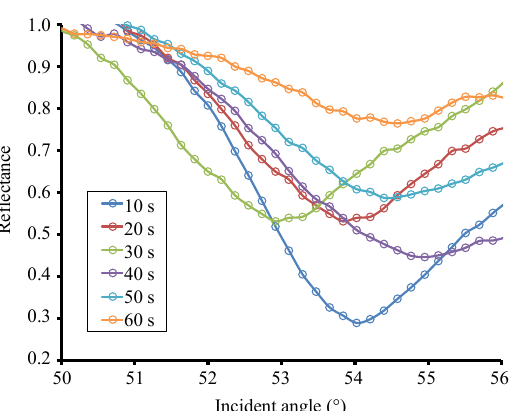
Fig. 2 Measured resonance signals for Fe 2 H 2 O 4 sensing layer deposited at different times.